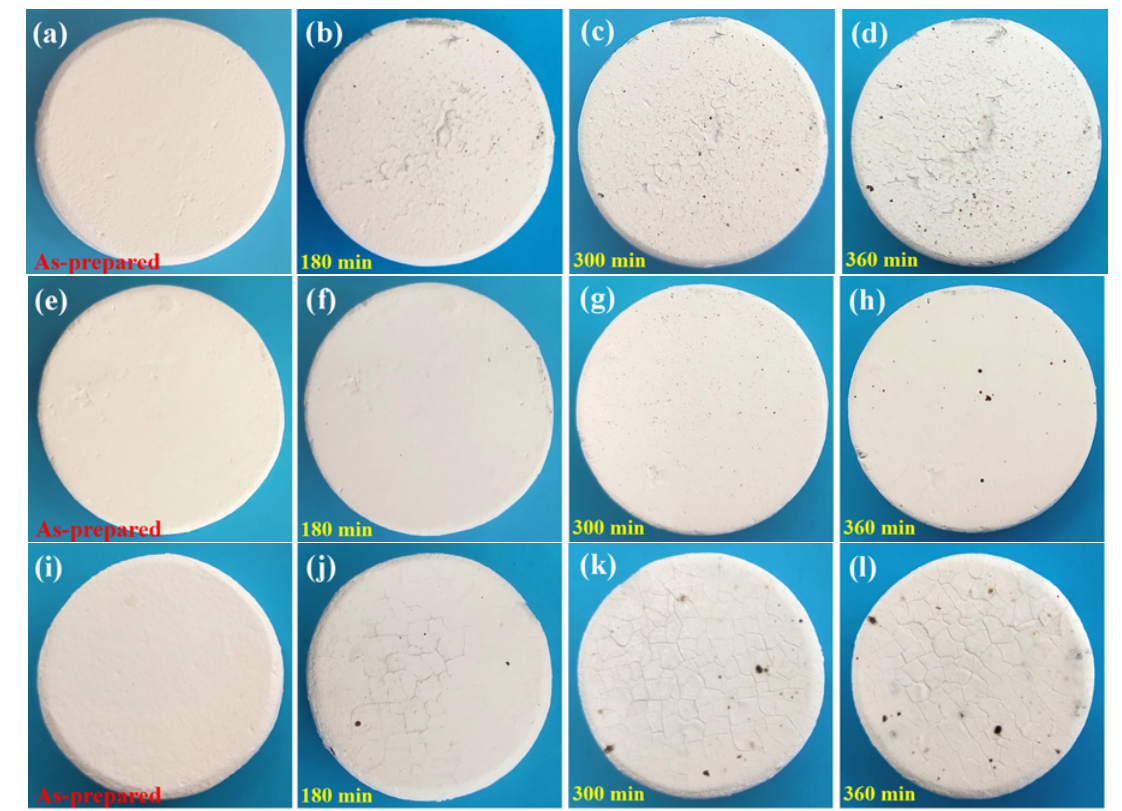
Fig. 7 Changes in the morphology of tri-layer (a–d) Yb 2 Si 2 O 7 /mullite/SiC, (e–h) Yb 2 Si 2 O 7 /SM/SiC, and (i–l) Yb 2 Si 2 O 7 / ASM/SiC coatings-coated C f /SiC samples in the burner rig test at 1673 K with the scouring time.